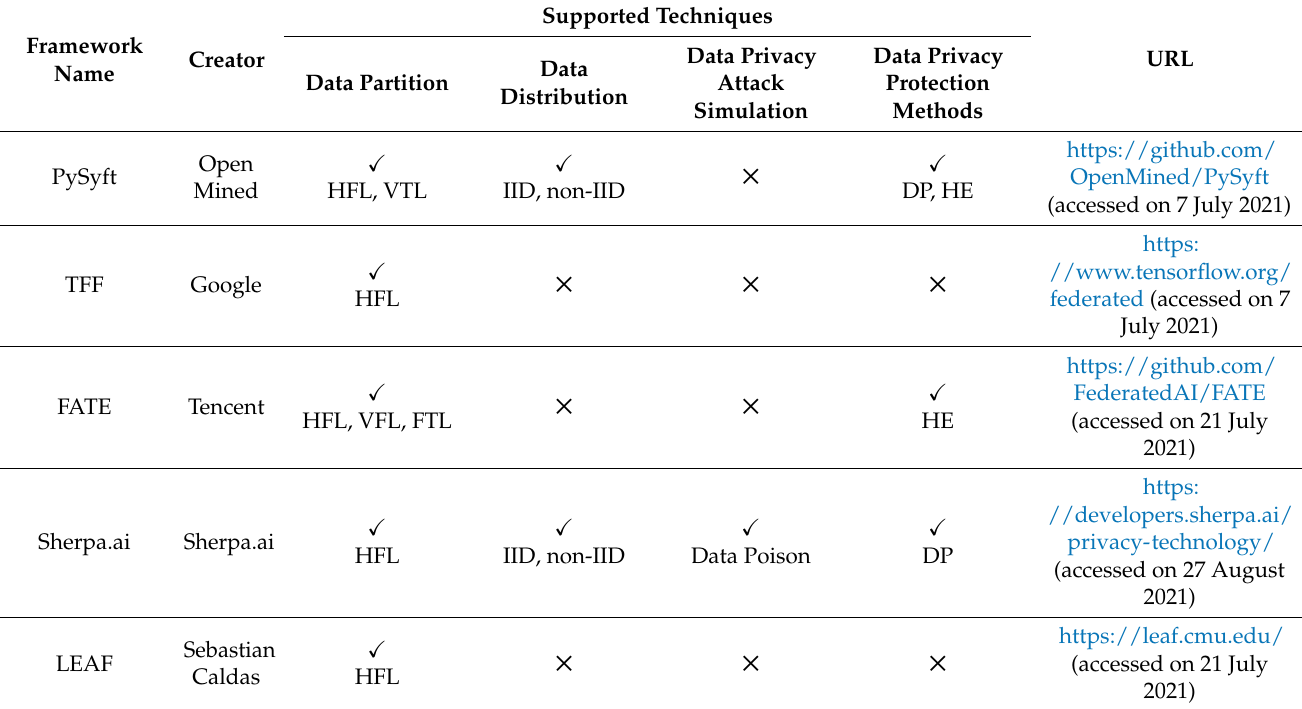
Table 4. Federated learning